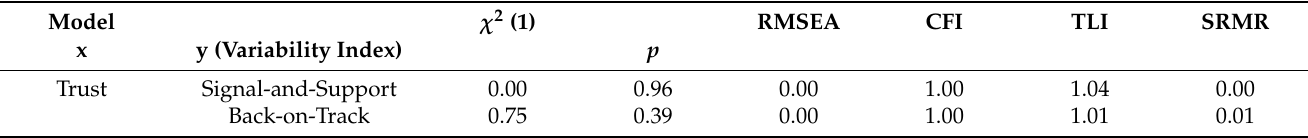
Table 3. Model fit indices for RI-CLPMs with Trust with freely estimated (unconstrained) within-person parameters. Model Trust